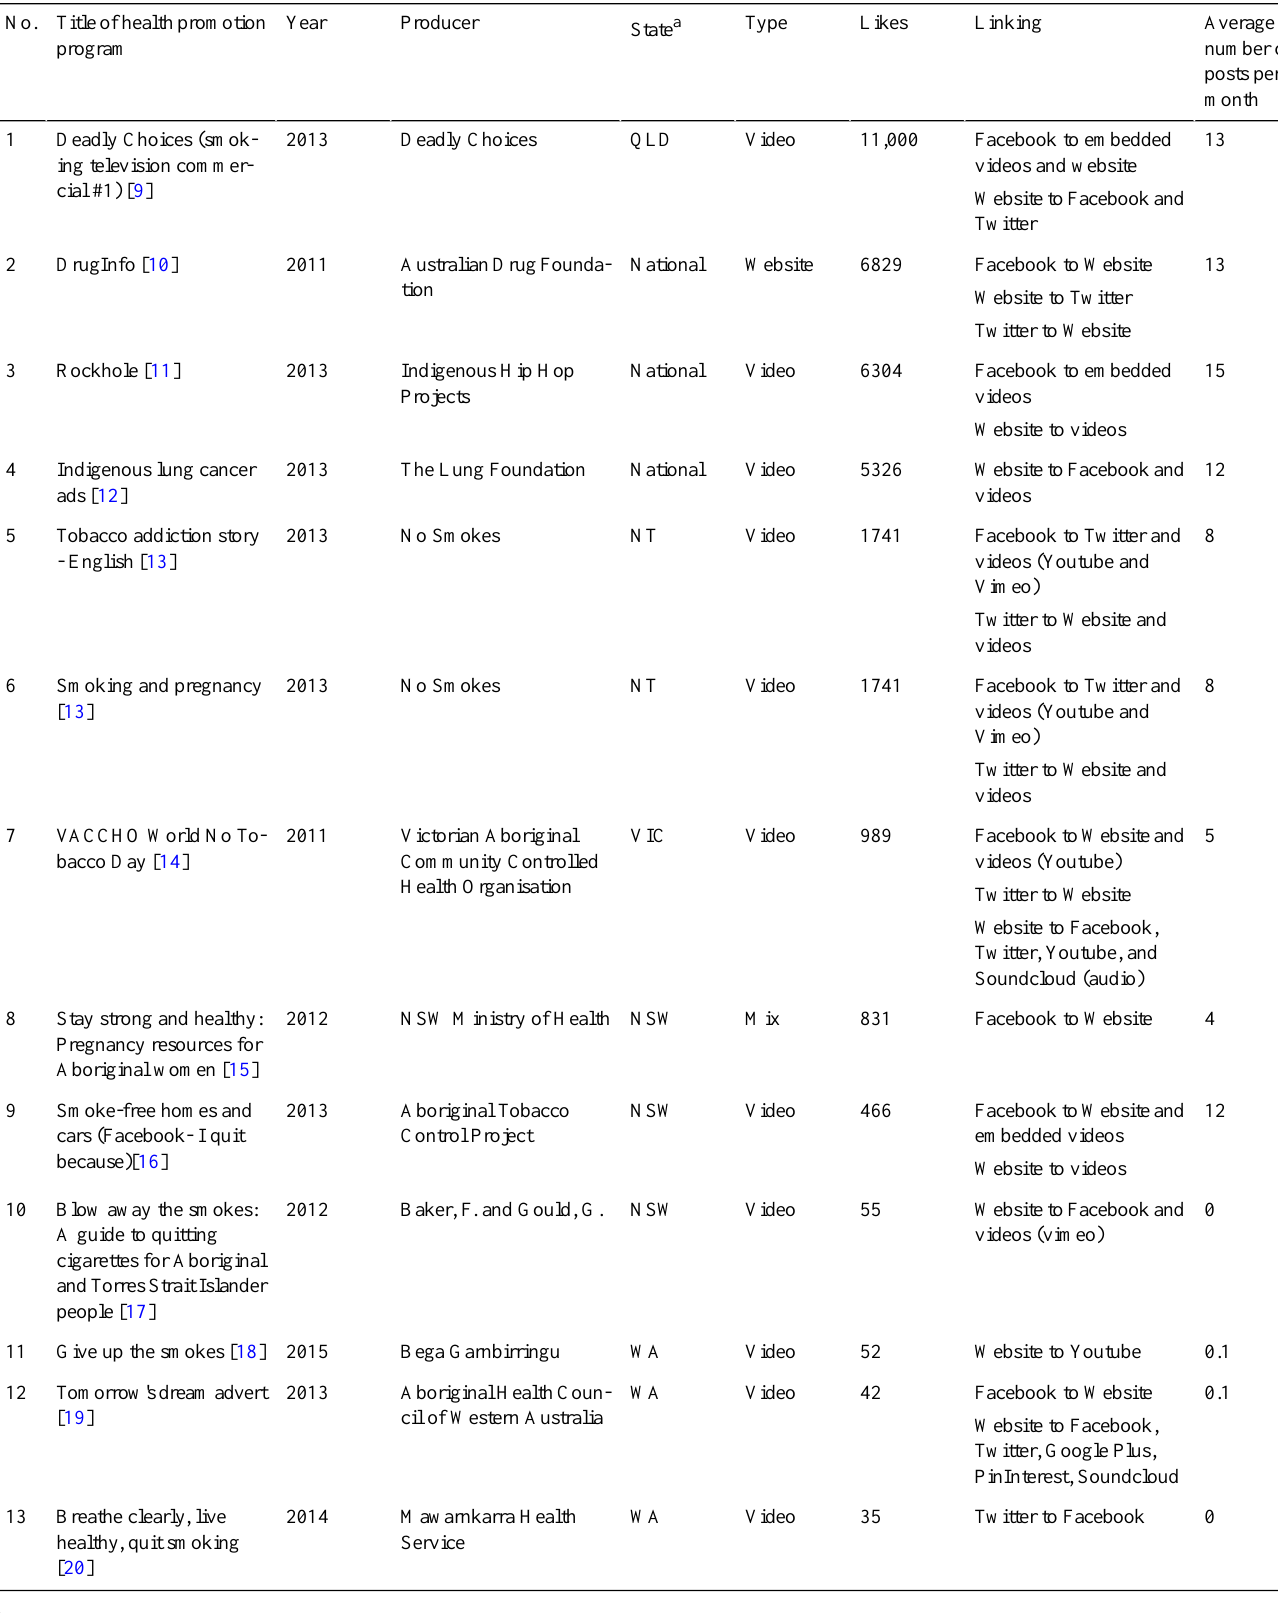
Table 4. Ranking of Facebook tobacco prevention and cessation